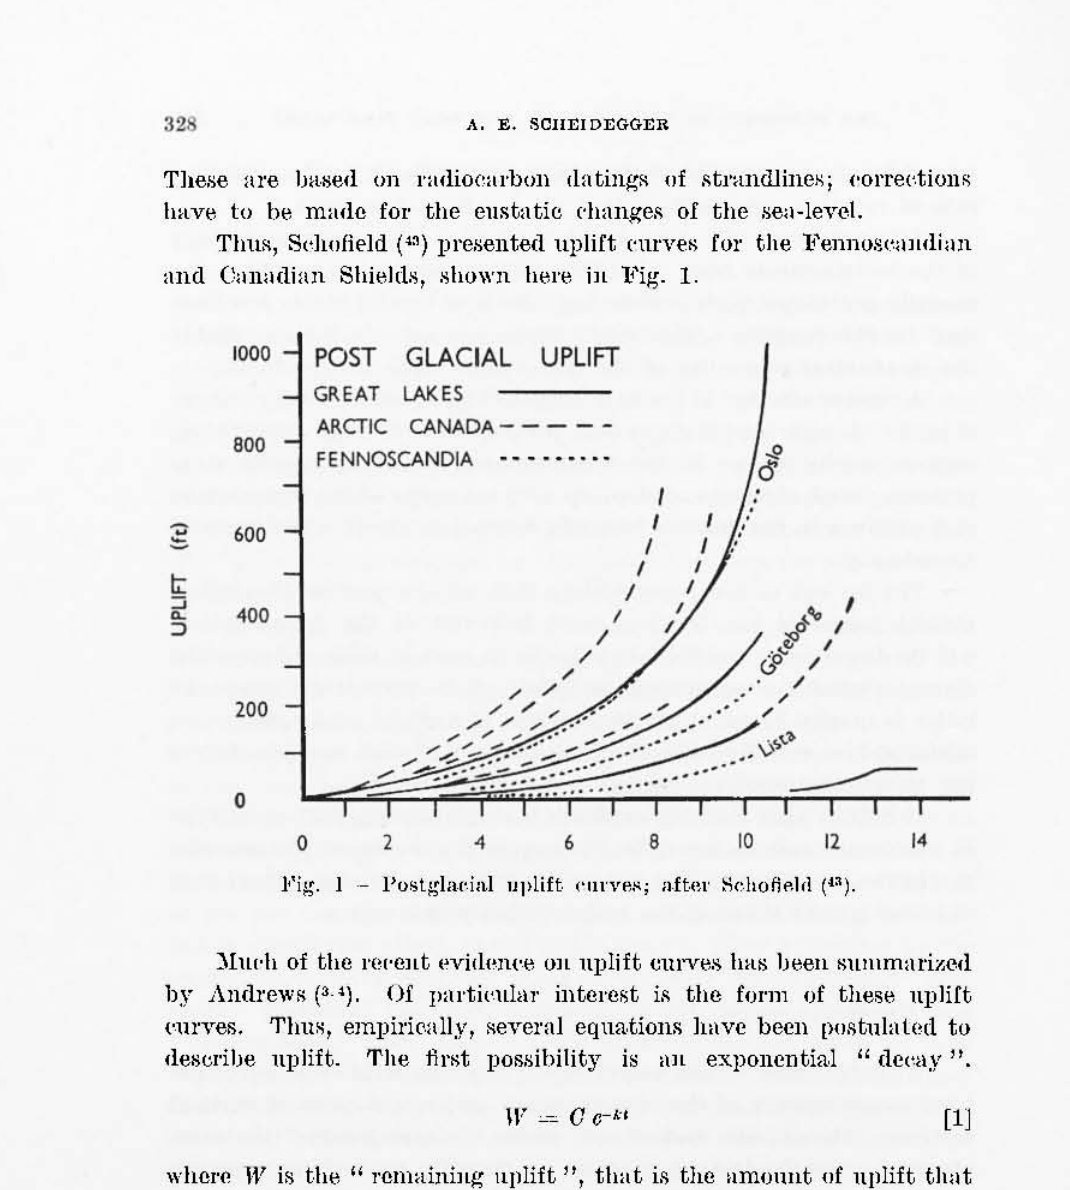
Fig. 1- l'ustglm'ial uplift (·Ill'VIl.~; afte\' ~khofilll(l